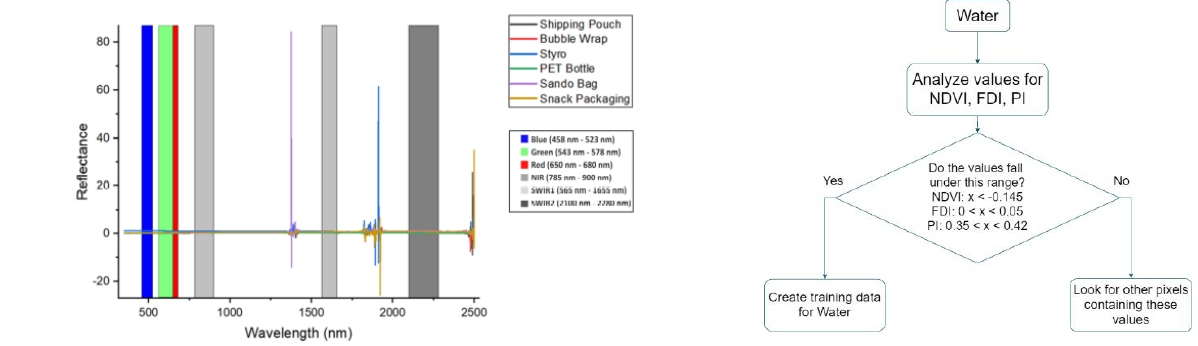
Figure 1 . Raw spectral reflectance curves for various types of plastic wastes.